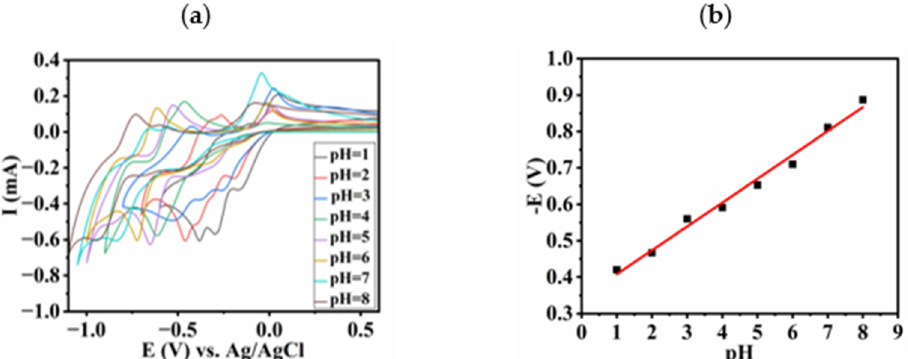
Figure 9. CVs of the ITO/(Cu 4 P 4 W 30 /PDDA-GO) 7 electrode in different pH solutions from 1 to 8 con- taining 10 µm 2,4-DNPH with scan rate: 50 mV·s − 1 ( a ) and the relationship of reduction potentials and the solution pHs ( b ).